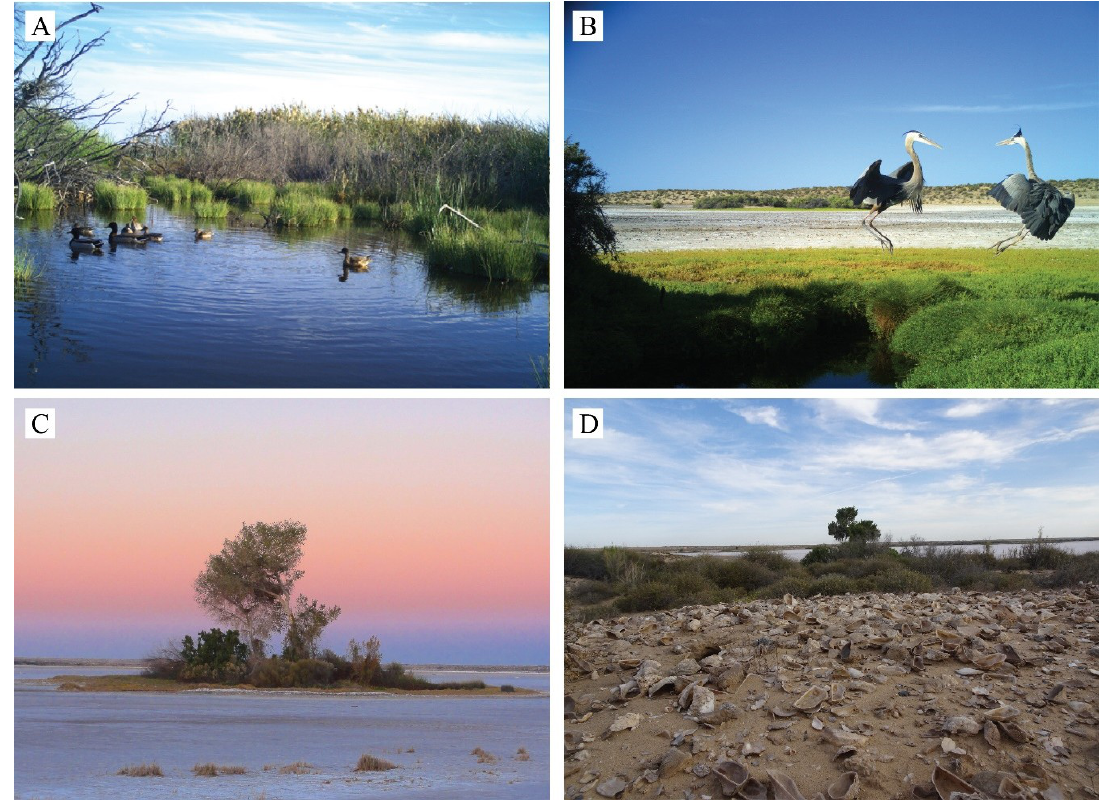
Figure 2. The pozos of El Gran Desierto. ( A ) Pond in La Salina, ( B ) pozo Tres Ojitos, ( C ) cottonwood (Populus fremontii) near La Salina, and ( D ) prehistoric shell midden at La Salina. Photo credits: Benjamin T. Wilder and Benjamin M. Johnson.